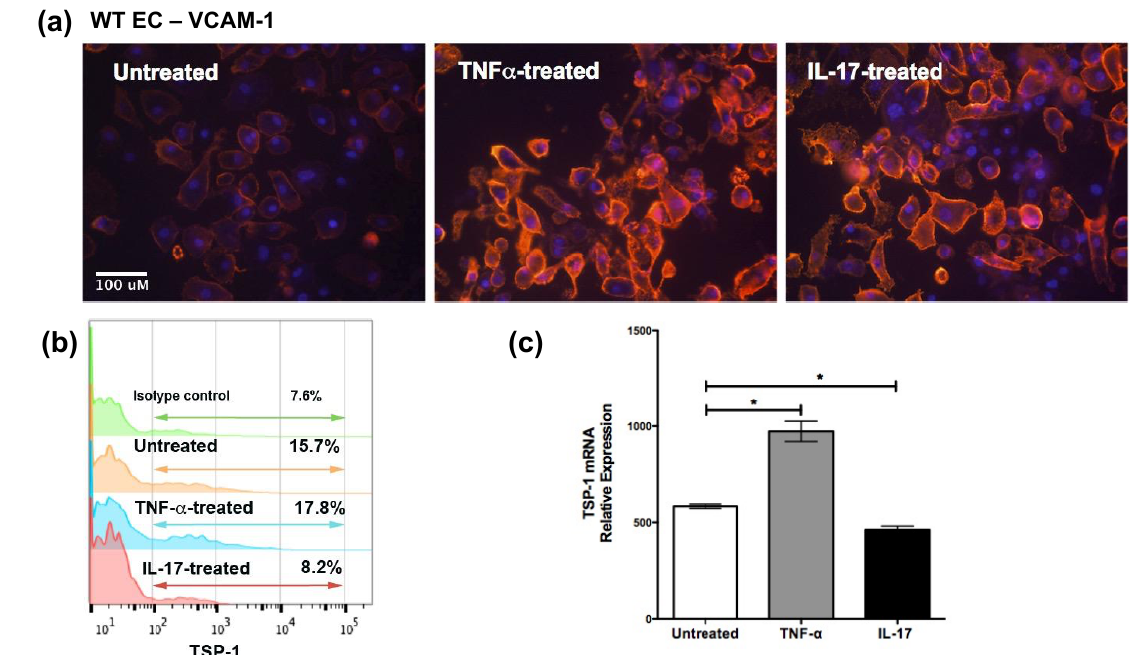
Figure 4. IL-17 and TNF- α both increase expression of VCAM-1 on vascular endothelial cells but differentially modulate endogenous TSP-1 expression. Primary cultures of murine vascular endothelial cells were treated with TNF- α (10 ng/mL) or IL-17 (10 ng/mL) for 24 h. ( a ) Endothelial cells were immunostained with anti-VCAM-1 (red), as described in Materials and Methods (200× magnification), nuclei stained with DAPI (blue) ( b ) Intracellular TSP-1 in permeabilized endothelial cells was detected by flow cytometry. Percentage indicates the proportion of cells positively stained for TSP-1, ( c ) Real-time PCR was performed on RNA isolated from endothelial cells to detect TSP-1 message. Results are expressed as the mean ± SEM ( n = 3 per experiment; * p < 0.05).